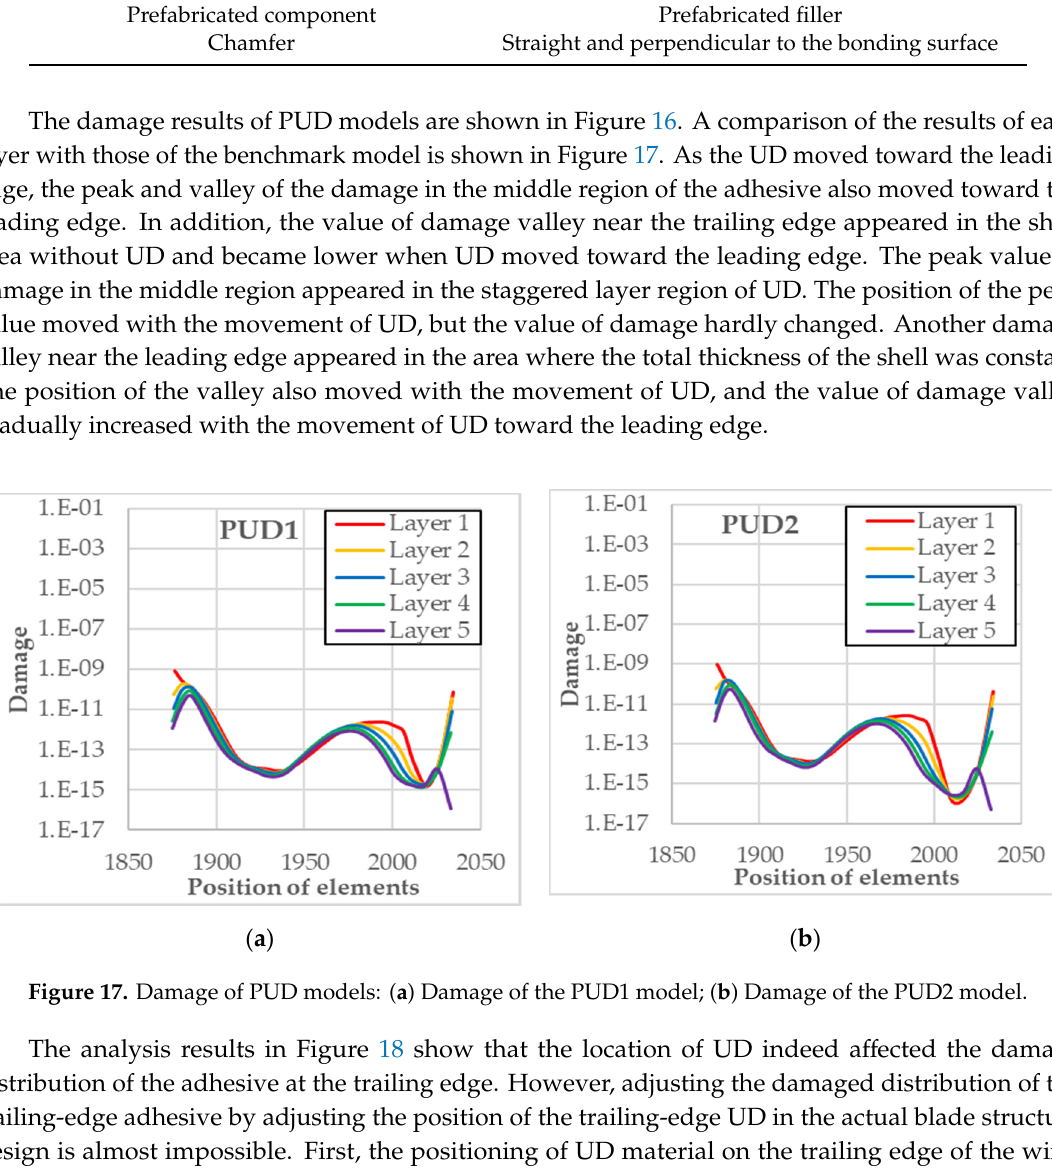
Figure 16. Differences between PUD and benchmark models: ( a ) Position of UD in the benchmark model was 20 mm; ( b ) Position of UD in the PUD1 model was 30 mm; ( c ) Position of UD in the PUD2 model was 40 mm.